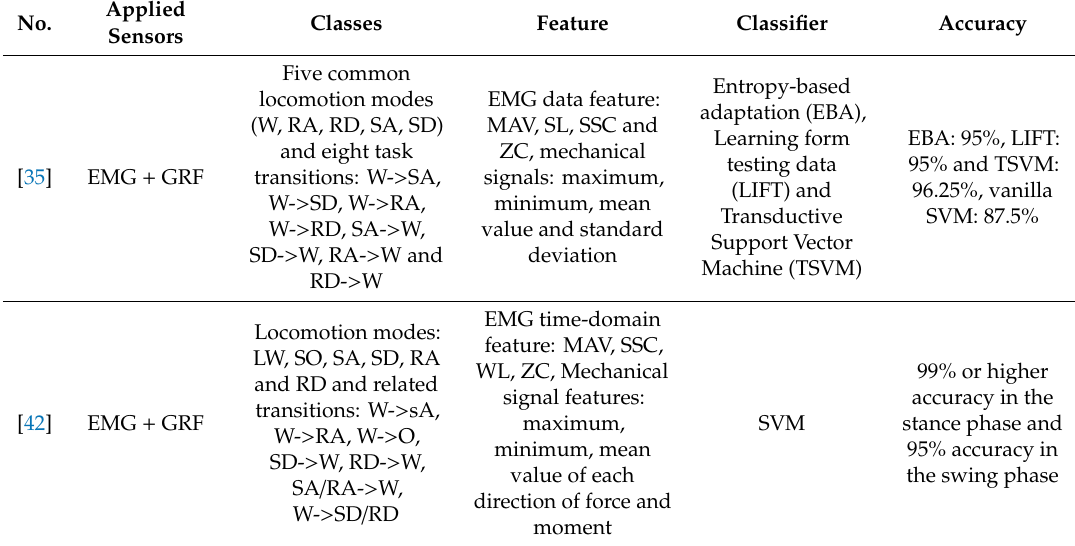
Table 2. Summary of the pattern recognition techniques applied in relevant